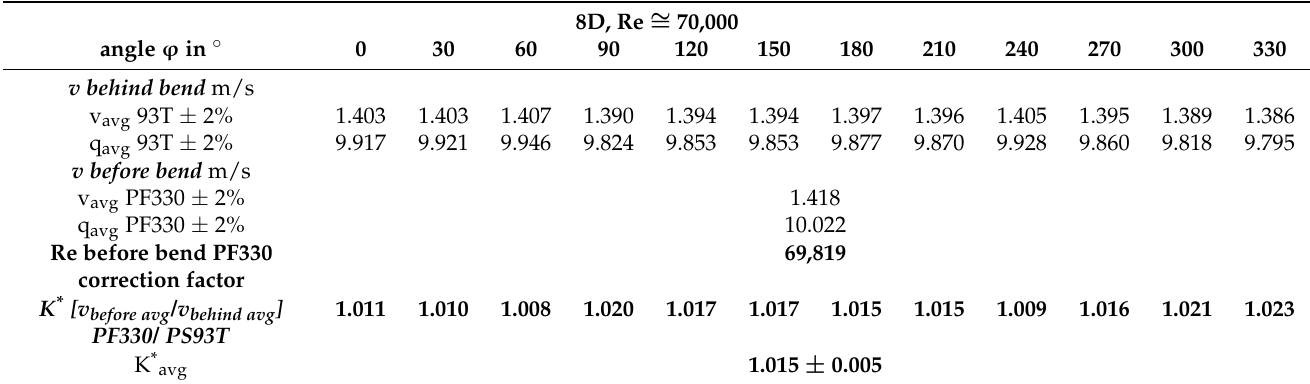
Table 7. Summary of the results of ultrasonic measurements for the 8D plane from the disturbing element as a function of the mounting angle of the ultrasonic flow meter heads, Re ∼ = 70,000.